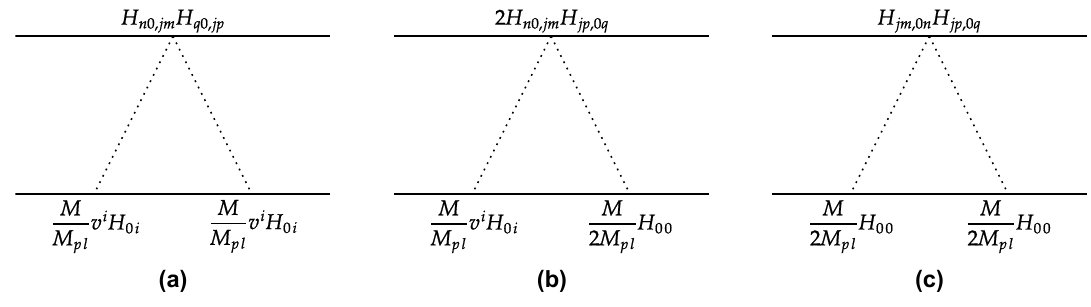
Figure 4 . Next to Leading Order